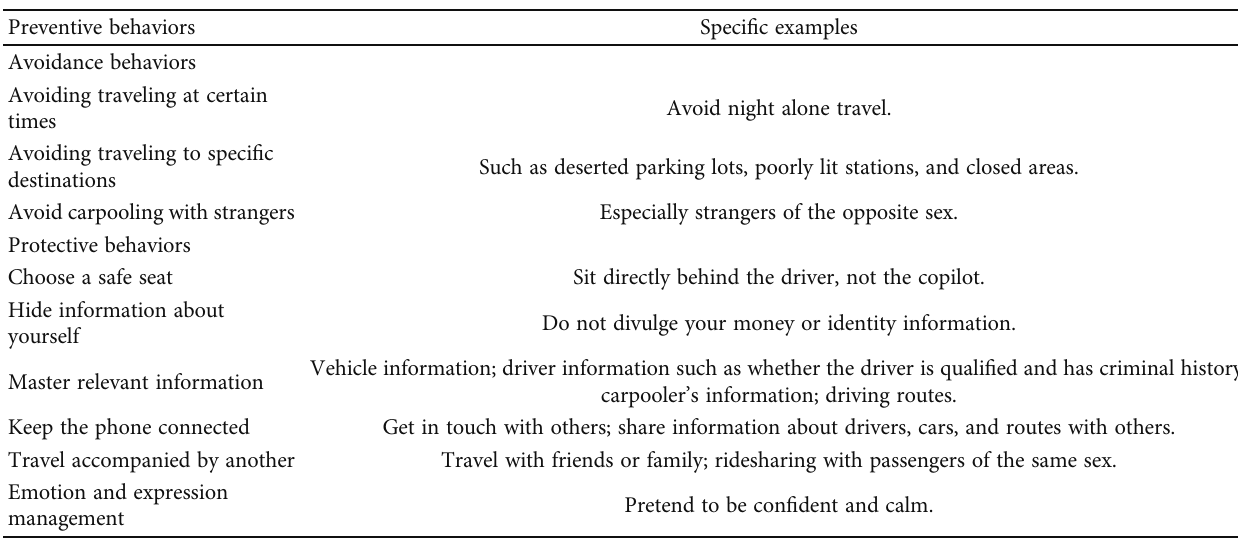
Table 7: Preventive behaviors for female